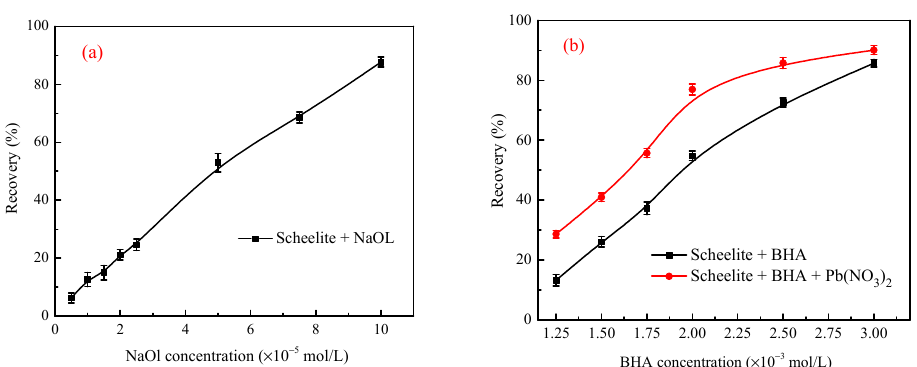
Figure 1. Effect of NaOL ( a ) and BHA ( b ) concentrations on the flotation recovery of scheelite (pH = 8.5).